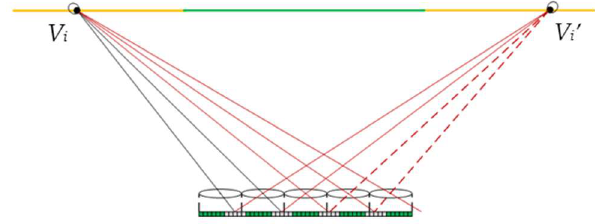
Figure 2. The emergence of the flipping image.